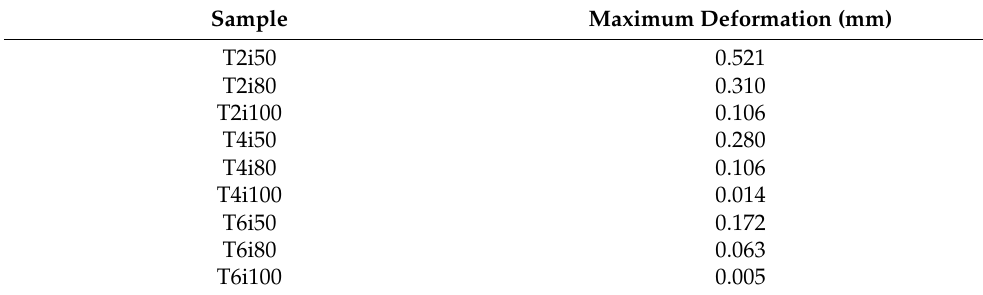
Table 4. Maximum deformation, in mm, of each plate subjected to a pressure of 6726 Pa.